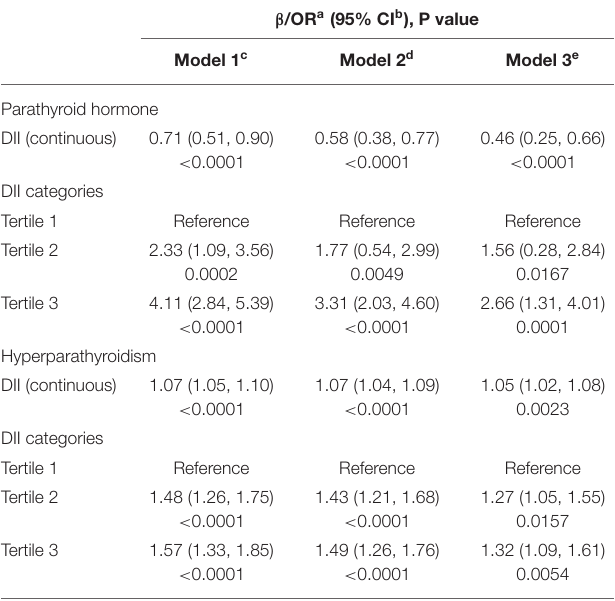
TABLE 3 | Association between DII, PTH, and HP, weighted. β /OR a (95% CI b ), P